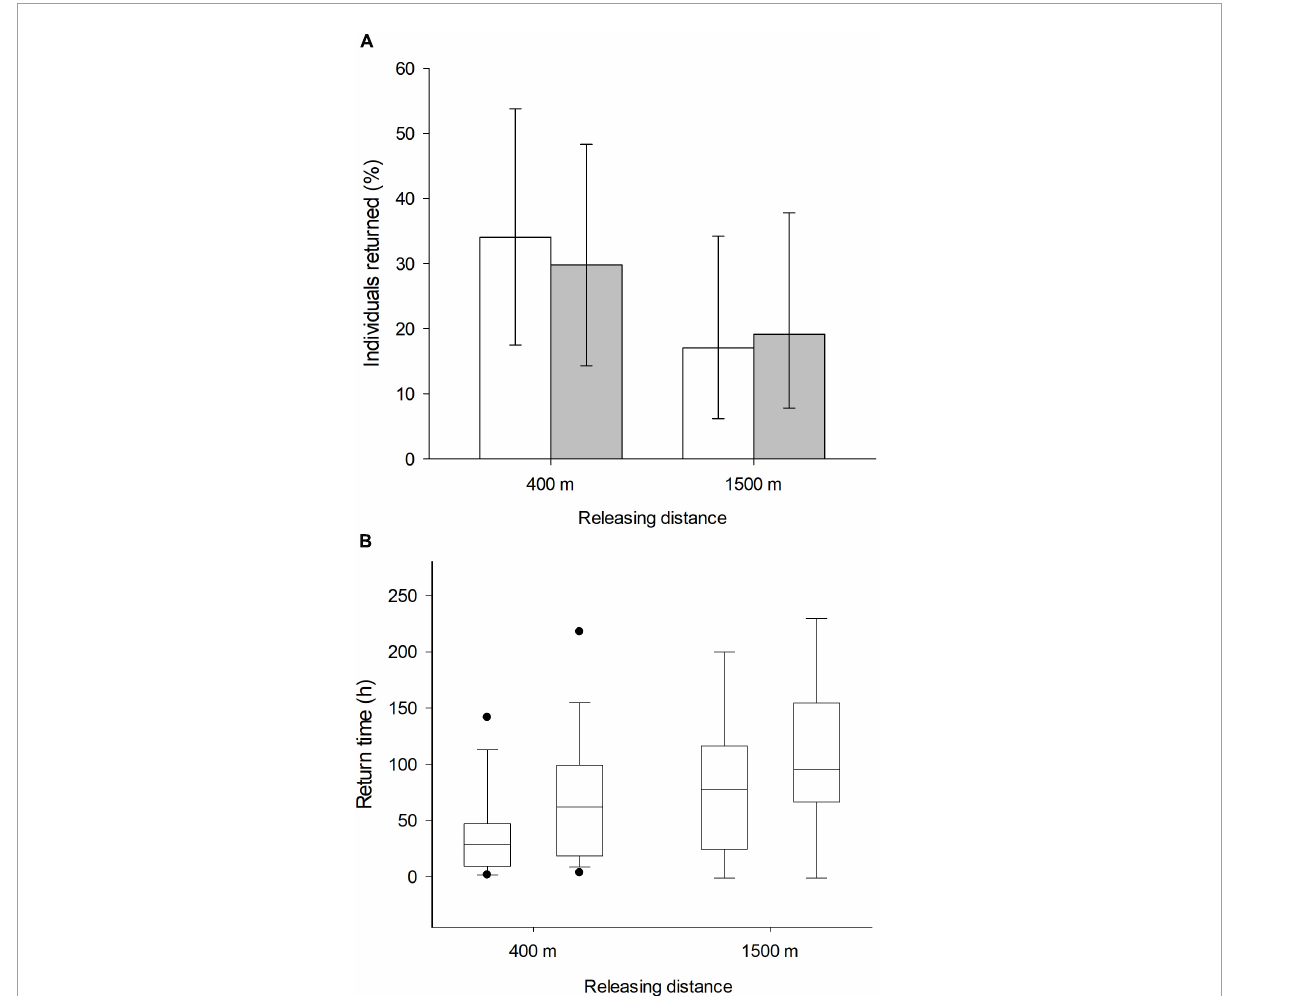
FIGURE1 Presented are (A) the average proportion (%) ± 95 confidence limits of birds returned to the feeder. Empty bars present the control group and gray bars the anosmic birds. The box plot (B) shows the time (in h) (medians, quartiles, 5th and 95th percentiles, and extreme values), great tits needed to return to the feeding site in relation to releasing distance (400 m/1,500 m) and their olfactory treatment (left control and right anosmic group,